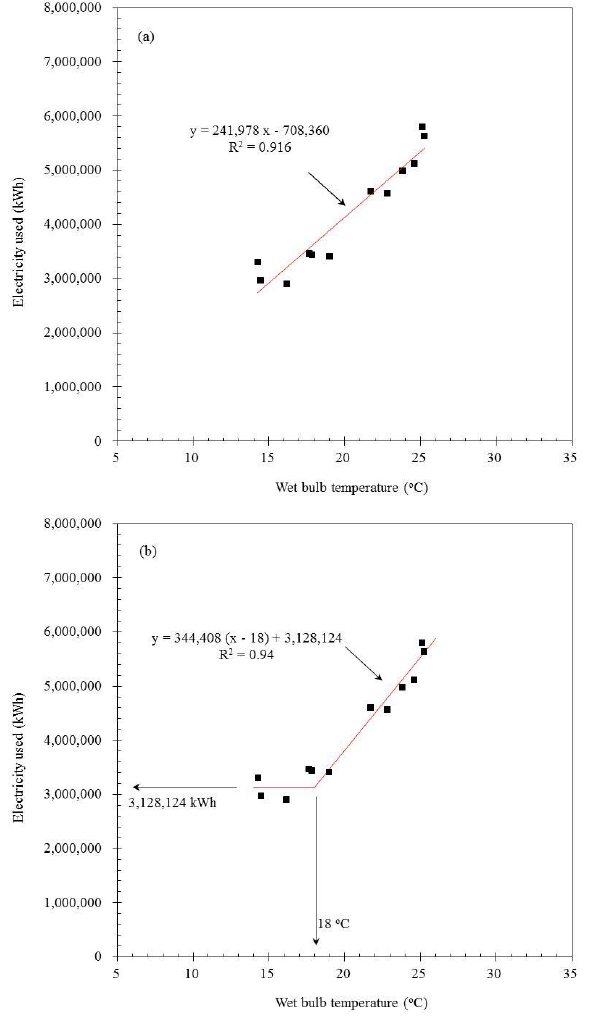
Figure 3. Correlation between chillers electricity usage and wet-bulb temperature. ( a ) Linear correlation model; ( b ) Three-parameter change-point model.